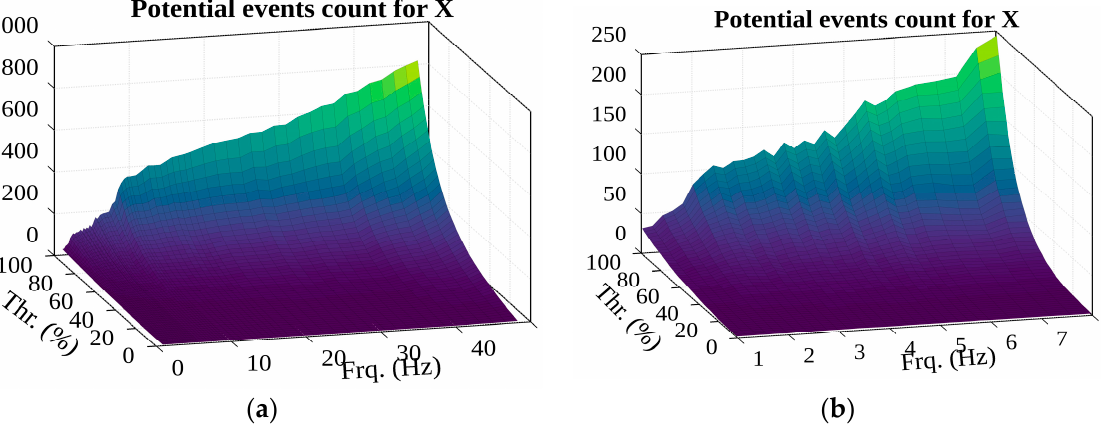
Figure 22. The surface of potential events X f (in the ( a )—1–49 Hz; ( b )—1–8 Hz frequency range).